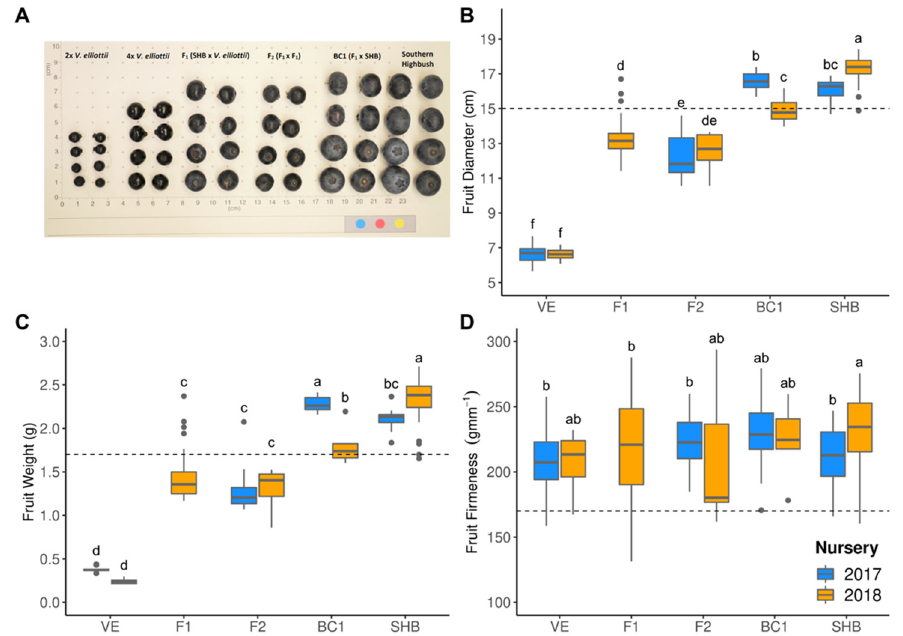
Figure 2. Fruit size, fruit weight, and fruit firmness observed for five stages of blueberry breeding. Fruit quality-related traits evaluated in five stages of blueberry breeding: V. elliottii (VE), F 1 , F 2 , BC 1 , and Southern highbush (SHB) families. ( A ) Berry size and color, ( B ) Breeding values obtained for fruit diameter, ( C ) Breeding values obtained for fruit weight, and ( D ) Breeding values obtained for fruit firmness. Treatments with the same letters are not statistically different at alpha = 0.05.